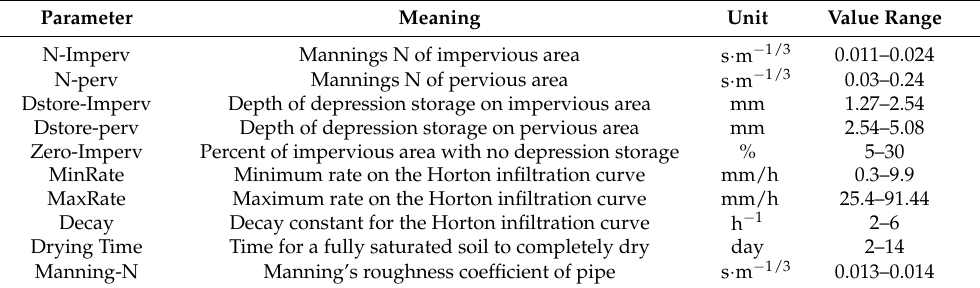
Table 1. Major hydrological, hydraulic parameters of SWMM, and their value ranges.